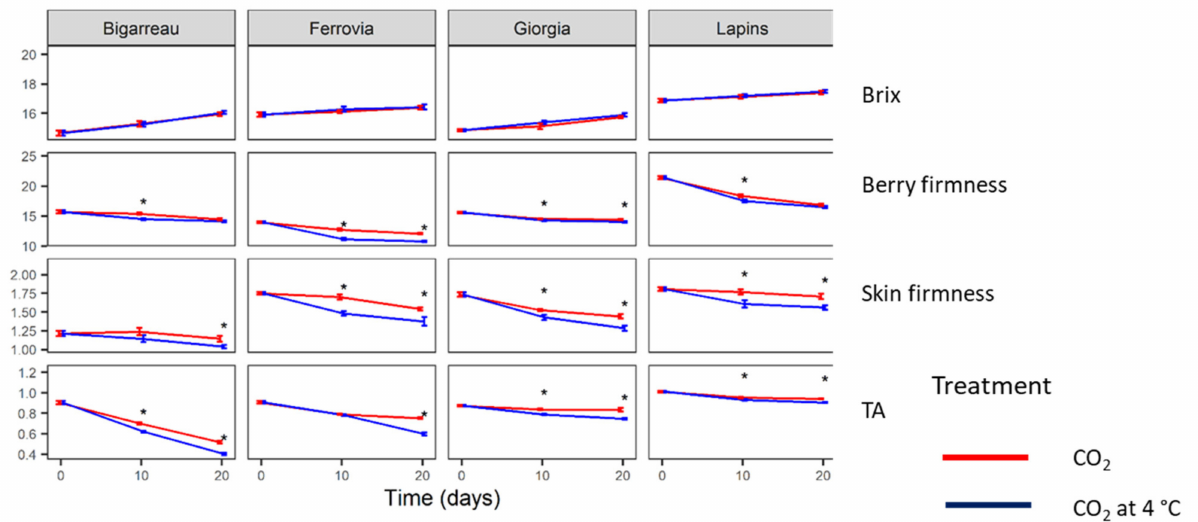
Figure 3. Brix (%), berry firmness (cN), skin firmness (cN), and TA (titratable acidity, g/L) measured in the fruits of four cherry cultivars that were treated with CO 2 with or without refrigeration (4 ◦ C). Asterisks indicate significant difference between treatments, according to the Tukey’s HSD test ( p <